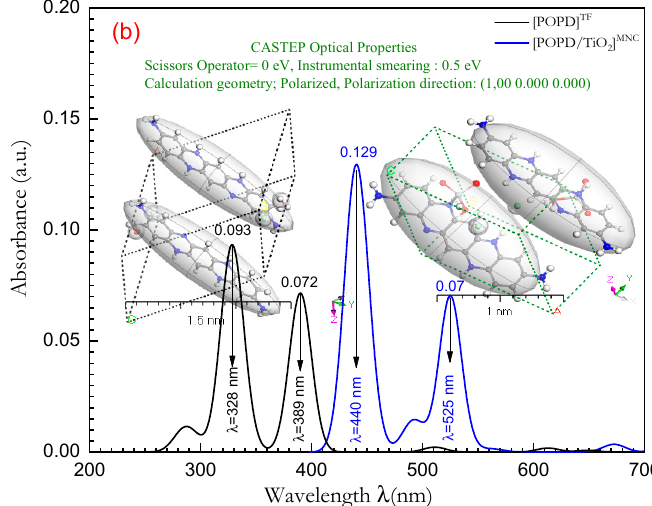
Figure 7. ( a ) UV–Vis absorption measurements of [PoPDA] TF and [PoPDA/TiO 2 ] MNC films, ( b ) sim- ulated absorption of [PoPDA] TF and [PoPDA/TiO 2 ] MNC using CASTEP. Using absorption coefficient α , which was calculated using the relation: α = 2.303 A / x , where x is the film thickness, the minimum energy required to move the electron from valence to conduction band, which is known as the optical energy gap ( E opt g ), can be calculated using Tauc’s relation: